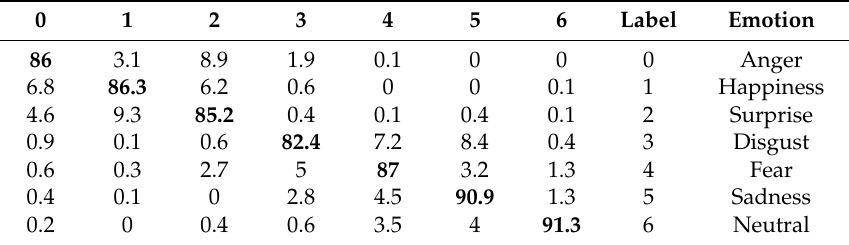
Table 11. Confusion matrix using the proposed